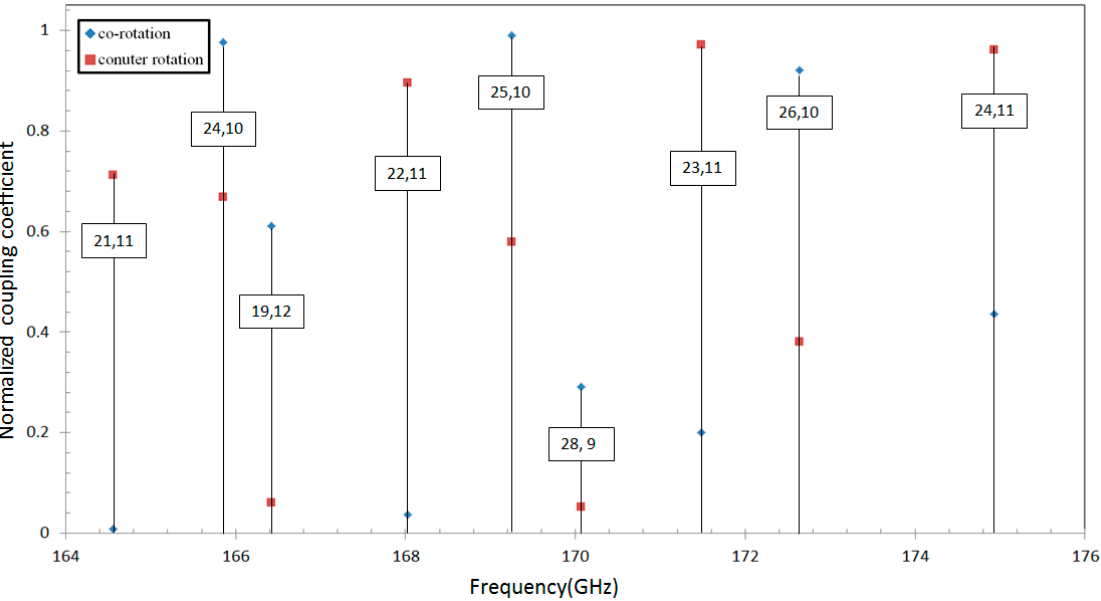
Figure 3. Normalized coupling efficiency for the competing modes at various frequency points. The TE 25,10 mode was chosen to the main mode for the 170 GHz gyrotron.